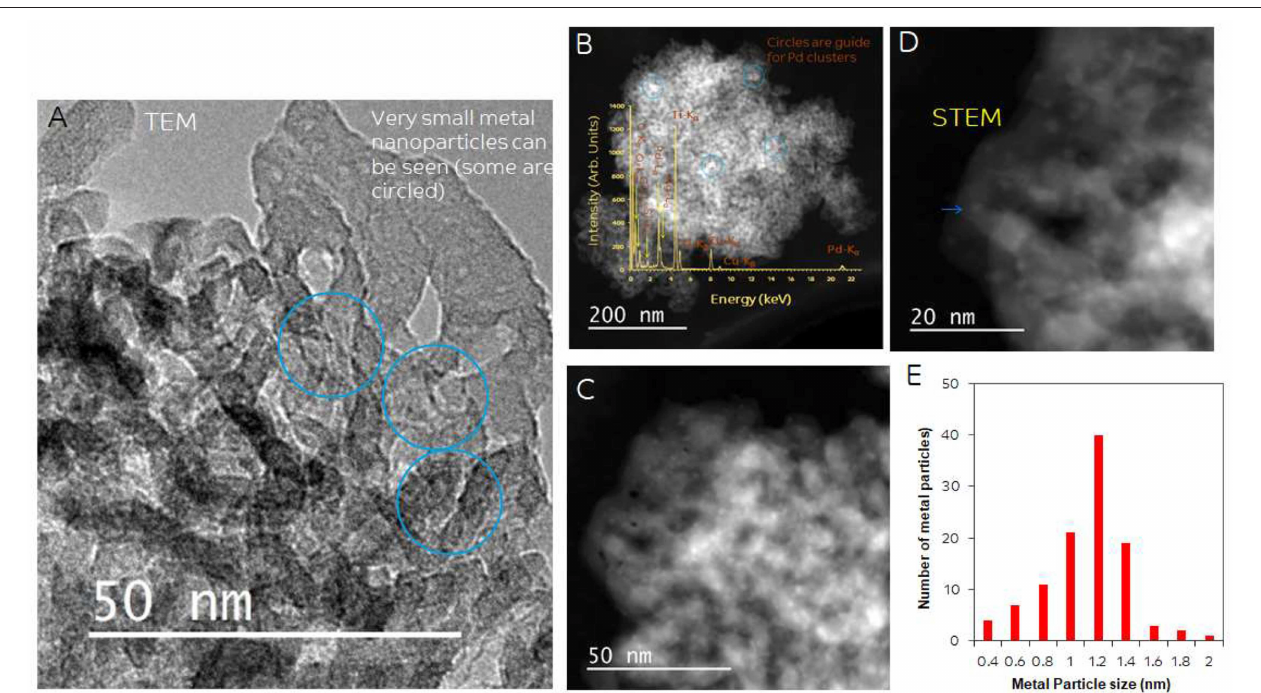
FIGURE 1 | (A) TEM of 0.1 wt.% Ag-TiO 2 , 0.1 wt.% Ag-0.3 wt.% Pd-TiO 2 ; the blue circles show some of the dark spots due to Pd and Ag. (B) STEM-HAADF (High-Angle Annular Dark-Field) image, inset: EDX of metal particles; (C,D) Higher magnification STEM showing Pd/Ag particle dispersion on top of TiO 2 . (E) Particle size distribution.